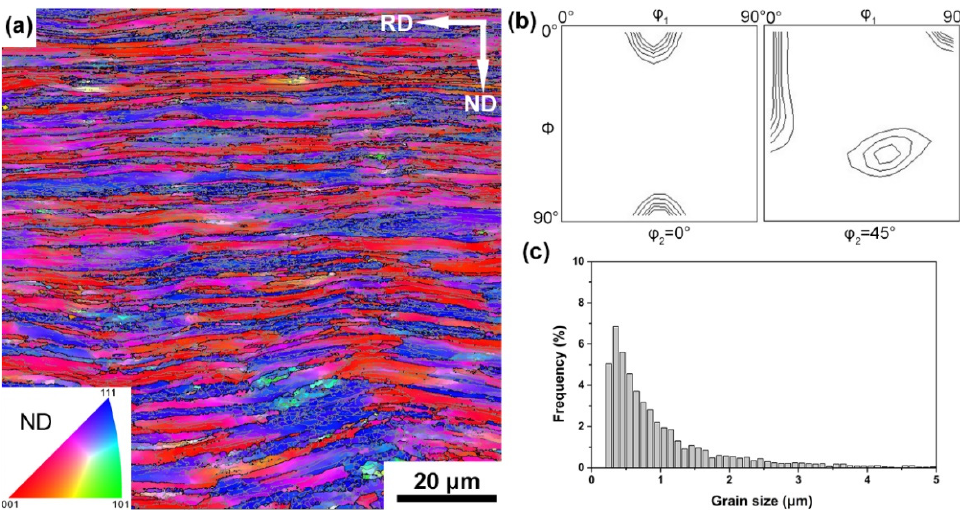
Figure 1. EBSD IPF grain orientation map ( a ), ODF sections representing the texture map ( b ) and the grain size distribution map ( c ) in as-rolled IF samples. Different colors in the maps correspond to different crystallographic directions along the ND as shown in the inset in ( a ). Contour layers of ODF: 1, 3, 5, 10, 20, 30, 40× random.